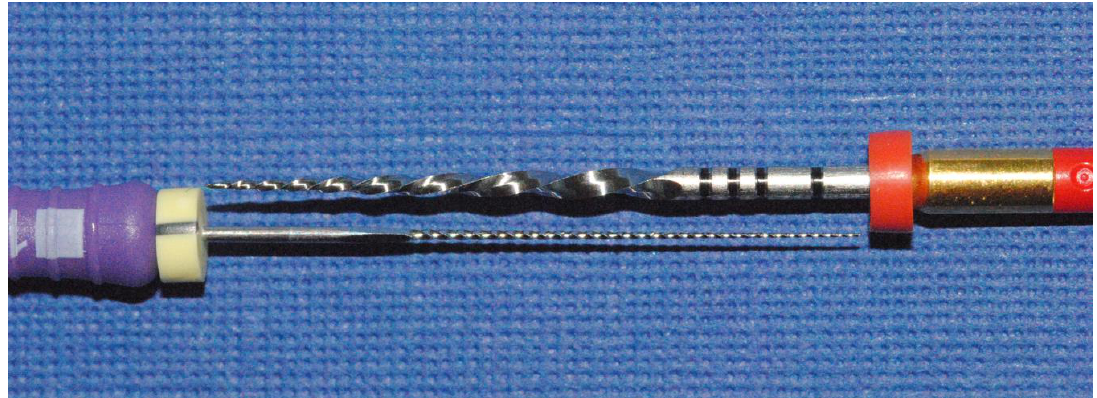
Figure 1. Experimental method (method II). Corresponding files are matched by placing them side by side from tip to shank in opposite directions in order to compare the length of the two instruments.